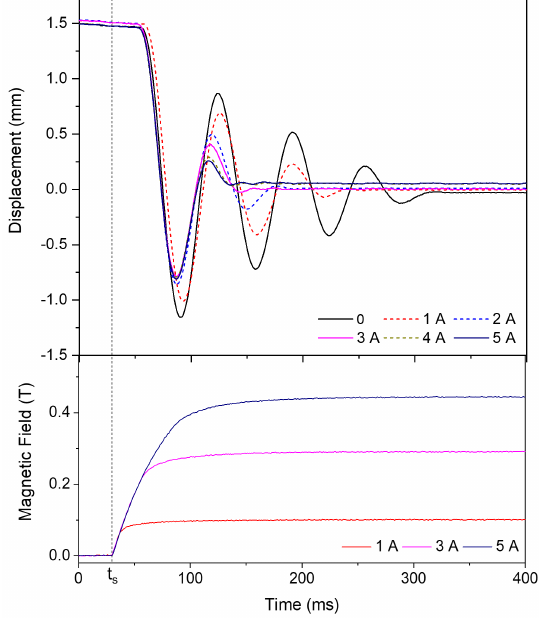
Figure 11. The mass displacement behaviour and the generated magnetic field in the MR damper with time at various current excitations based on ‘Config. A’.